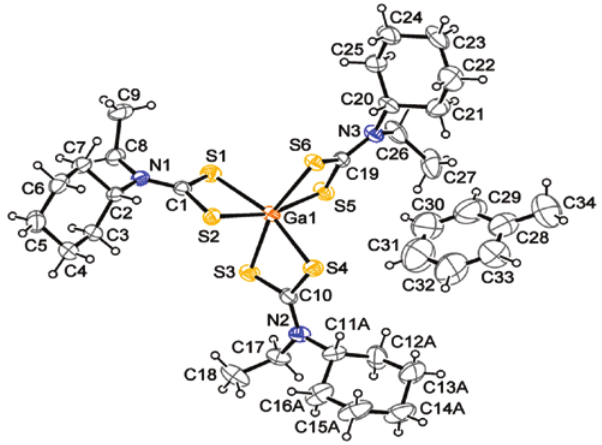
Figure 3: ORTEP of [Ga(chedtc) 40% probability ellipsoids were used for the presentation.